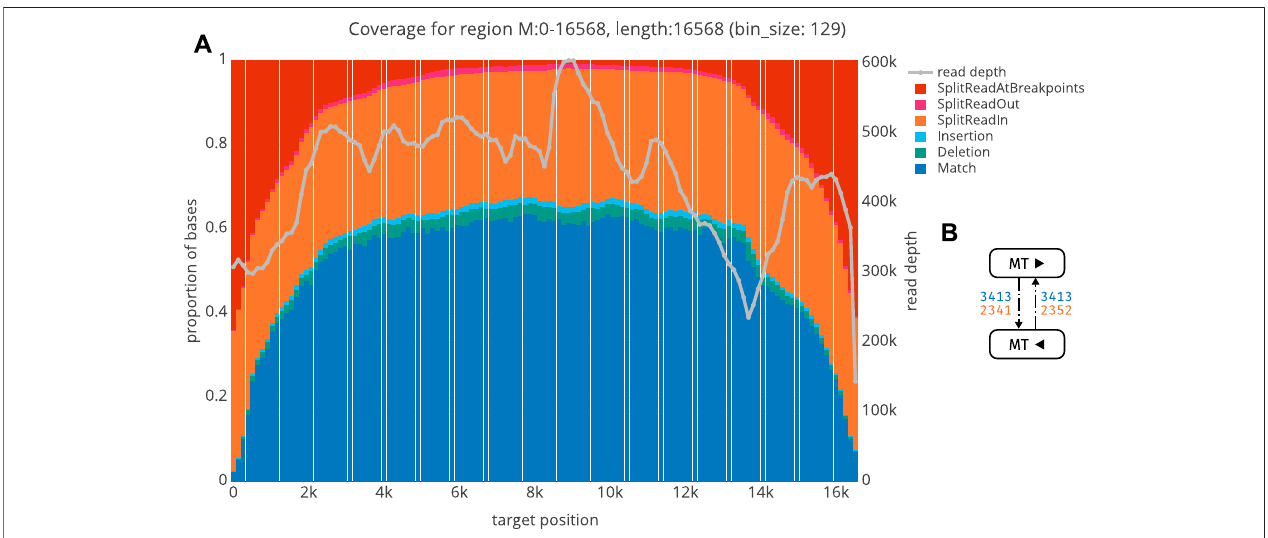
FIGURE 5 | A QC plot for the mitochondrion from Kelly sample. For each locus (bin), we obtain a summary of the number of matches (blue), insertions (cyan) and deletions (green) as well asthe number ofbasesbelonging to a split read either within the region (orange), spanning over both breakpoints (red), or linking to some other region (magenta). On the second y -axis, read depth is shown (grey) (B) Graph structure for the Kelly mitochondrion, with the same keys as in Figure 6 .